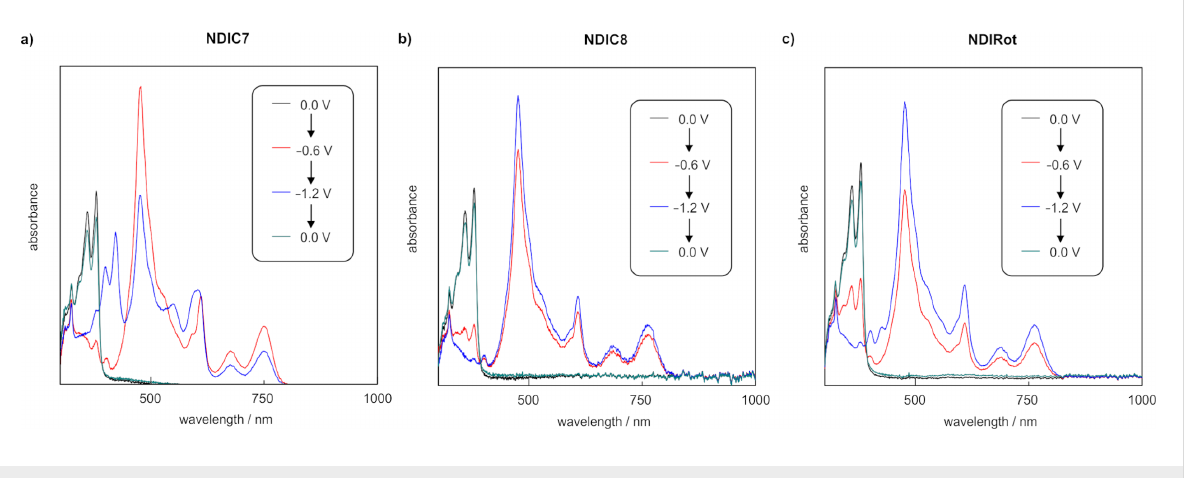
Figure 4: UV–vis–NIR spectra obtained by spectroelectrochemical measurements (0.1 M n -Bu 4 PF 6 , CH 2 Cl 2 /CH 3 CN 1:1, 298 K) of a) NDIC7 (0.5 mM), b) NDIC8 (0.5 mM), and c) NDIRot (1 mM). Potentials are referenced against a silver wire pseudo-reference electrode.